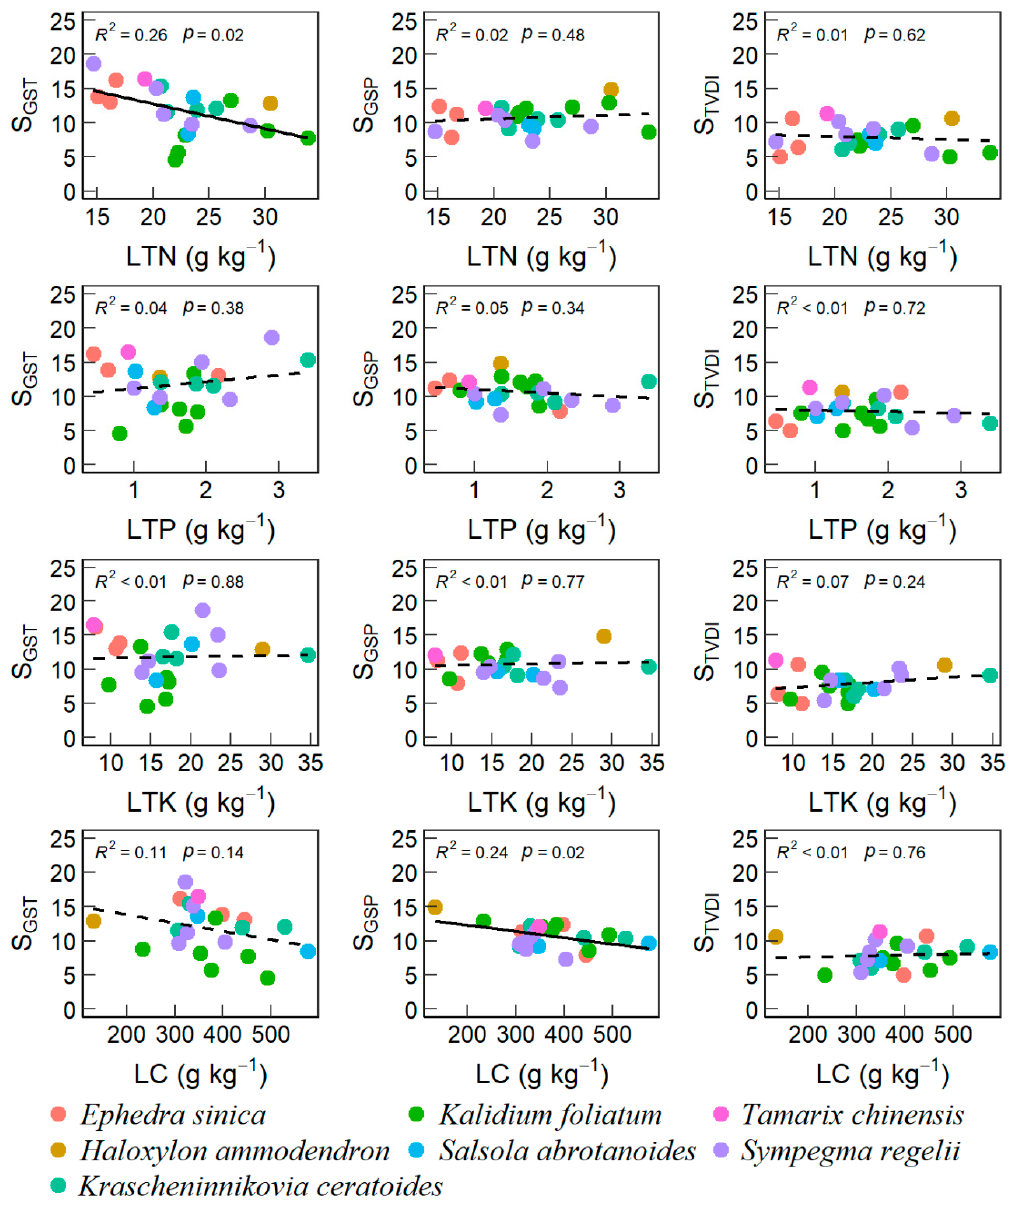
Figure 5. Trends of vegetation sensitivity index and its contributions with leaf nutrients. However, we also found differential responses, linear, U-shaped, and unimodal, for different top-dominant species along the soil and foliar nutrient gradients (Figures S7 and S8). When examining the relationships of sensitivity components with soil nutrients, we only found that the S GST of Kalidium foliatum and S TVDI of Sympegma regelii had unimodal relationships with SOC and STP, respectively, at a marginal significance level ( p < 0.1, Figure S7). When examining the relationships of sensitivity components with foliar nutrimental traits, we found a significant unimodal relationship between S TVDI and LC for Sympegma Regeli ( p < 0.05, Figure S8), a marginally positive linear relationship between S GSP and LTK for Kalidium foliatum ( p < 0.1, Figure S8), a significant unimodal relationship between S GSP and LTN for Kalidium foliatum , and a marginally positive linear relationship between S GST and LTP for Krascheninnikovia ceratoides ( p < 0.1, Figure S8). STN and LC explained 42.9% of the variance in VSI across different desert scrubs ( p < 0.05, Table 3). S GST was significantly affected by STN and LC, which accounted for 49.0% of the variance in S GST ( p < 0.01, Table 3). In addition to STN and LC, LTN and